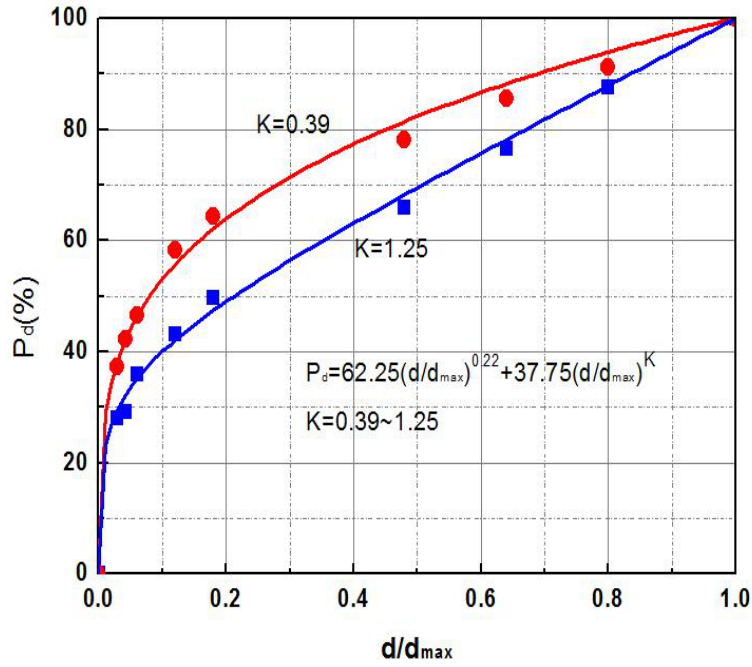
Figure 5. Fitting curves of the P d polynomial function of d / d max for the finest and coarsest aggregates of the autoclaved bricks in the high-strength region.